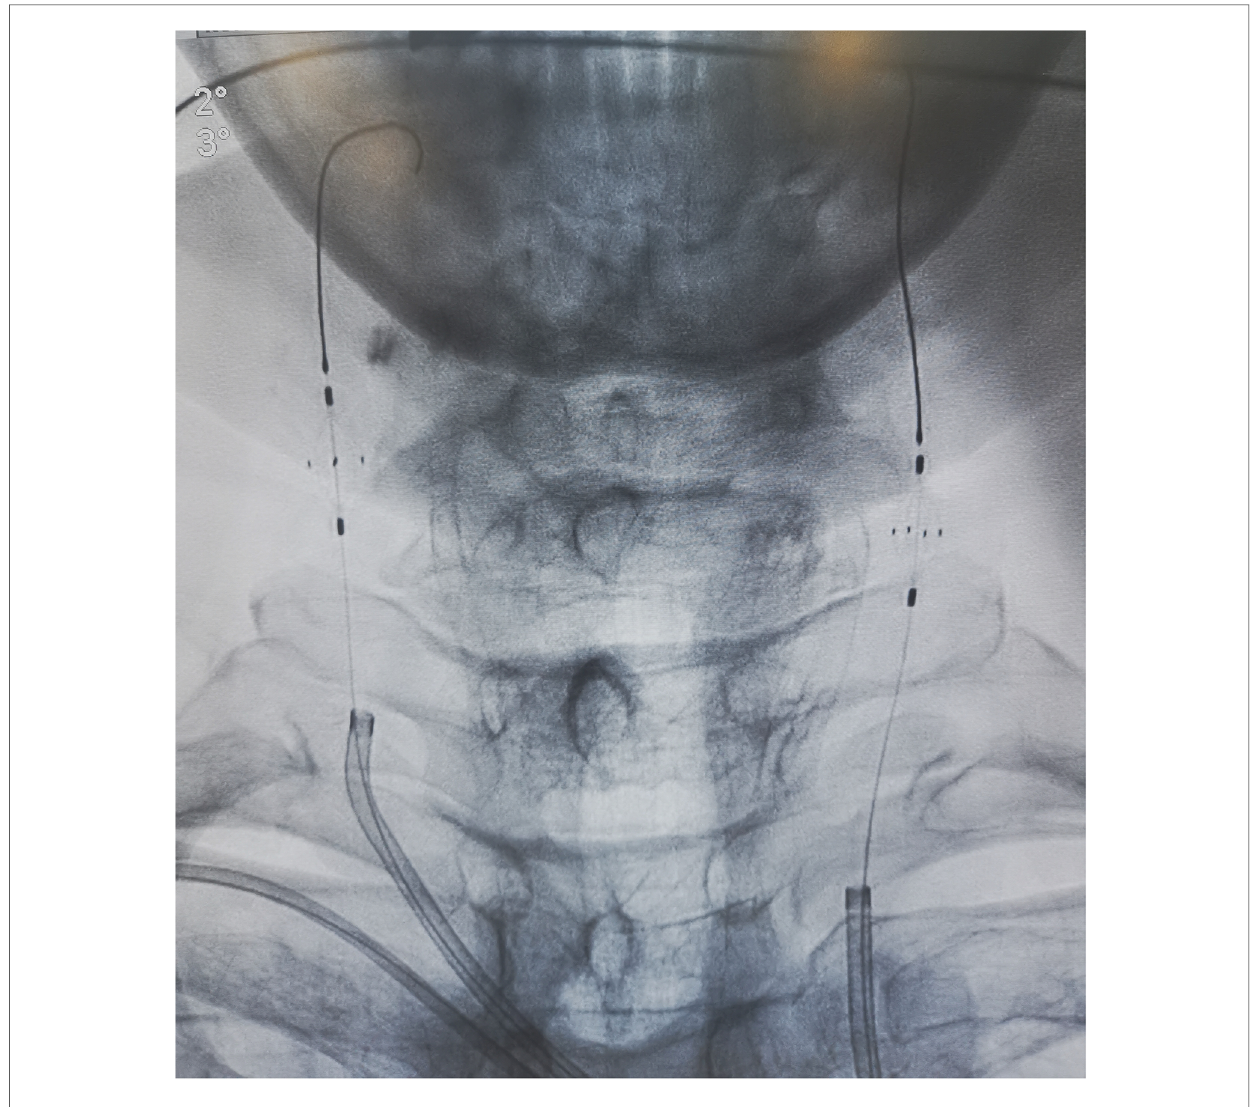
FIGURE 4 Angioguard umbrellas in both carotid